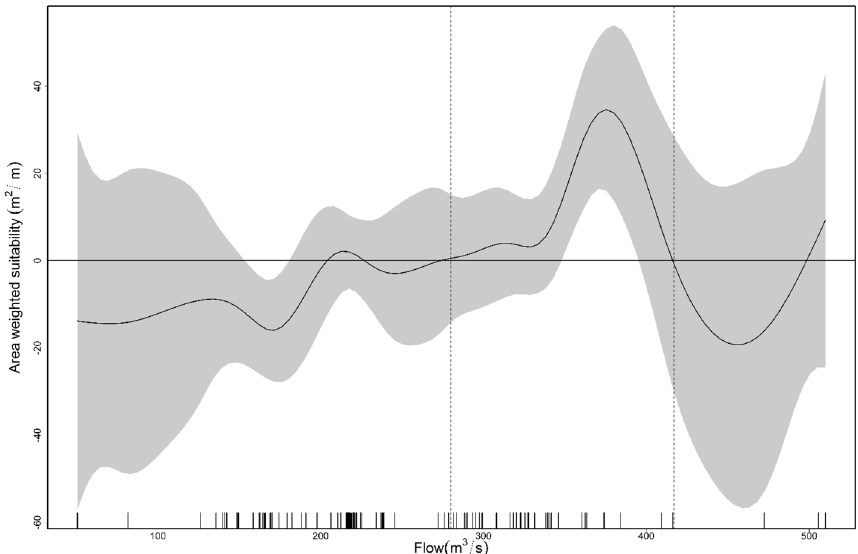
Figure 6. Ecological response (Area Weighted Suitability-AWS) of Ganges River dolphins as a function of flow in a continuous scale, where the smoothed curve line shows the estimated AWS as a function of flow variation, gray color represents the 95% CI level, and marks along the lower axis represent a single observation of the flow level. The two dotted vertical lines identify the limits for the optimum flow range that contribute positively to AWS, whereas the black horizontal line represents the zero effects zone.